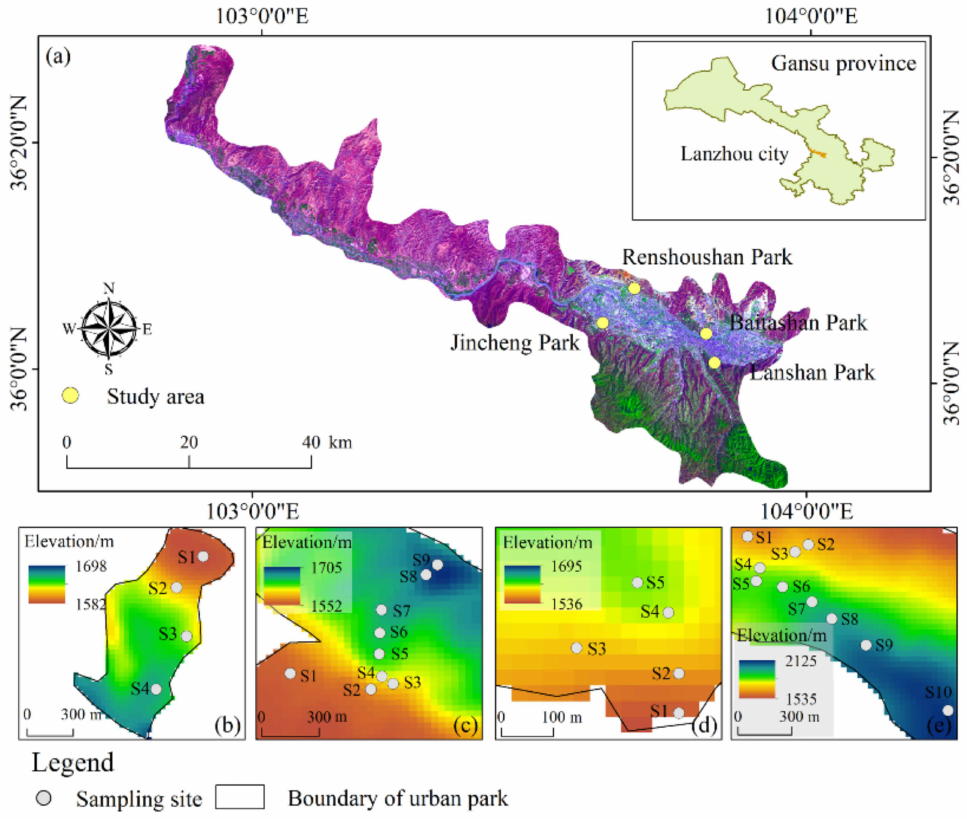
Figure 1. Overview of the study area ( a ) and distribution of sampling sites in Jincheng Park ( b ), Ren- shoushan Park ( c ), Baitashan Park ( d ), and Lanshan Parks ( e ). Lanshan, Baitashan, Renshoushan, and Jincheng Parks are representative of several urban parks in Lanzhou city (Figure 1). They are evenly distributed in the southern and northern mountains of the three urban districts including Chengguan, Anning, and Xigu. Among them, Lanshan Park is the largest (~3.47 km 2 ), whereas Jincheng Park is the smallest (~0.5 km 2 ). The parks were built from 1958 to 1987, so their levels of maturity vary. The dominant native trees in the parks are Sophora japonica , Ulmus pumila, Salix matsudana, Elaeagnus angustifolia, Ailanthus altissima, and Platycladus orientalis